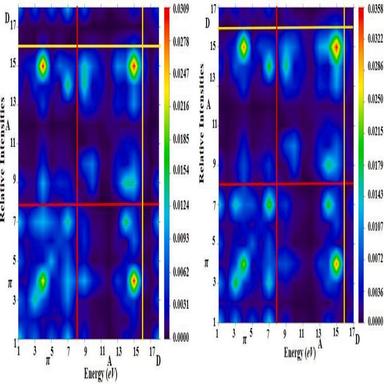
TDM graphs of all the synthesized compounds (EHT1-EHT5).